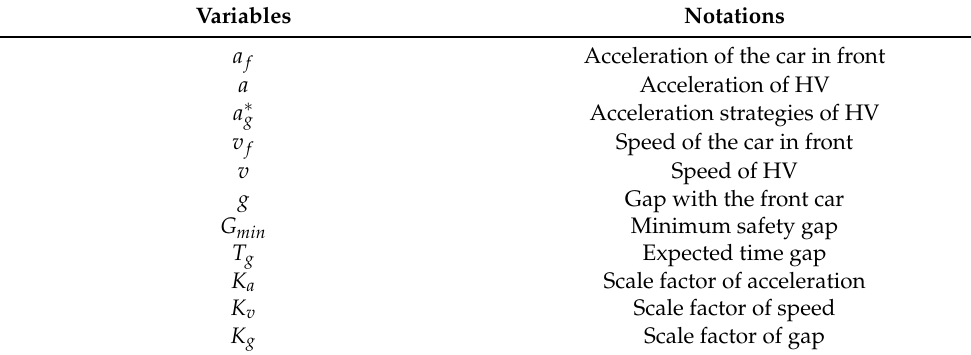
Table 6. Notations of PID-based CACC algorithm. Variables